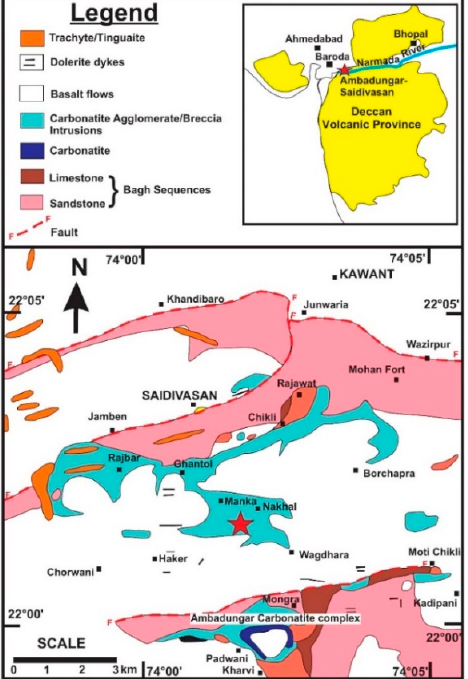
Figure 1. Geological map of the Ambadungar-Saidiwasan alkaline carbonatite complex, modified after [10,12,14,15]. Area of sample locations are marked by a red star. Inset: map shows location of the ASACC.